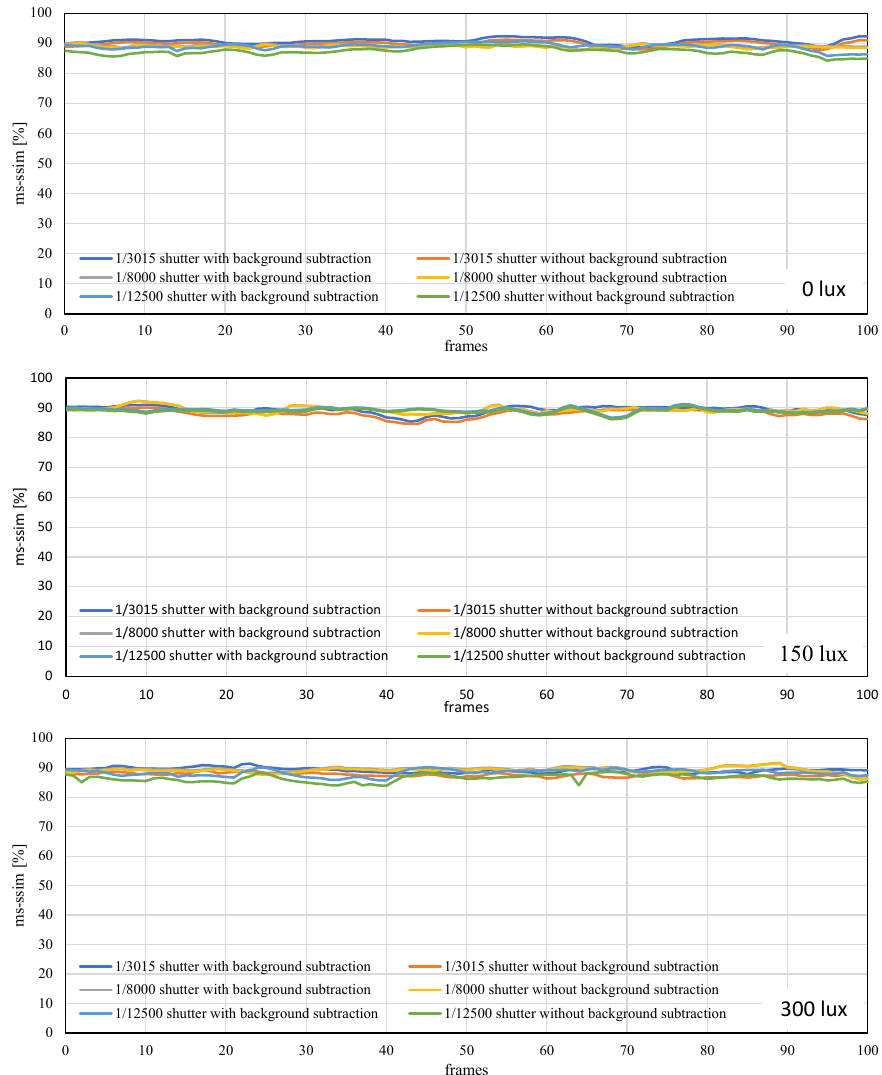
Figure 27. MS-SSIMs when the USB camera video sequence is streamed through HFR